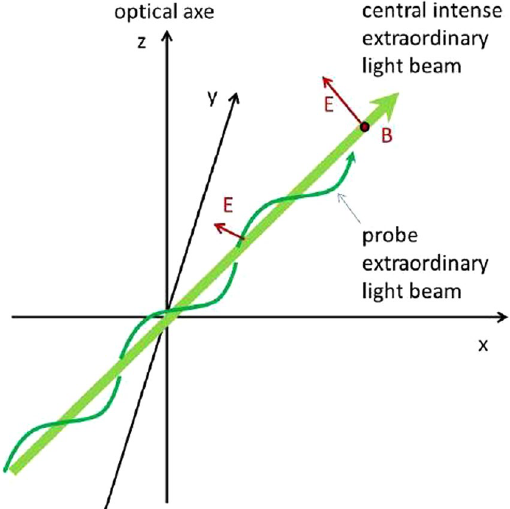
Figure 4. Experimental geometry which may be used to study effective gravitational interaction of extraordinary light beams in a ferrofluid-based hyperbolic